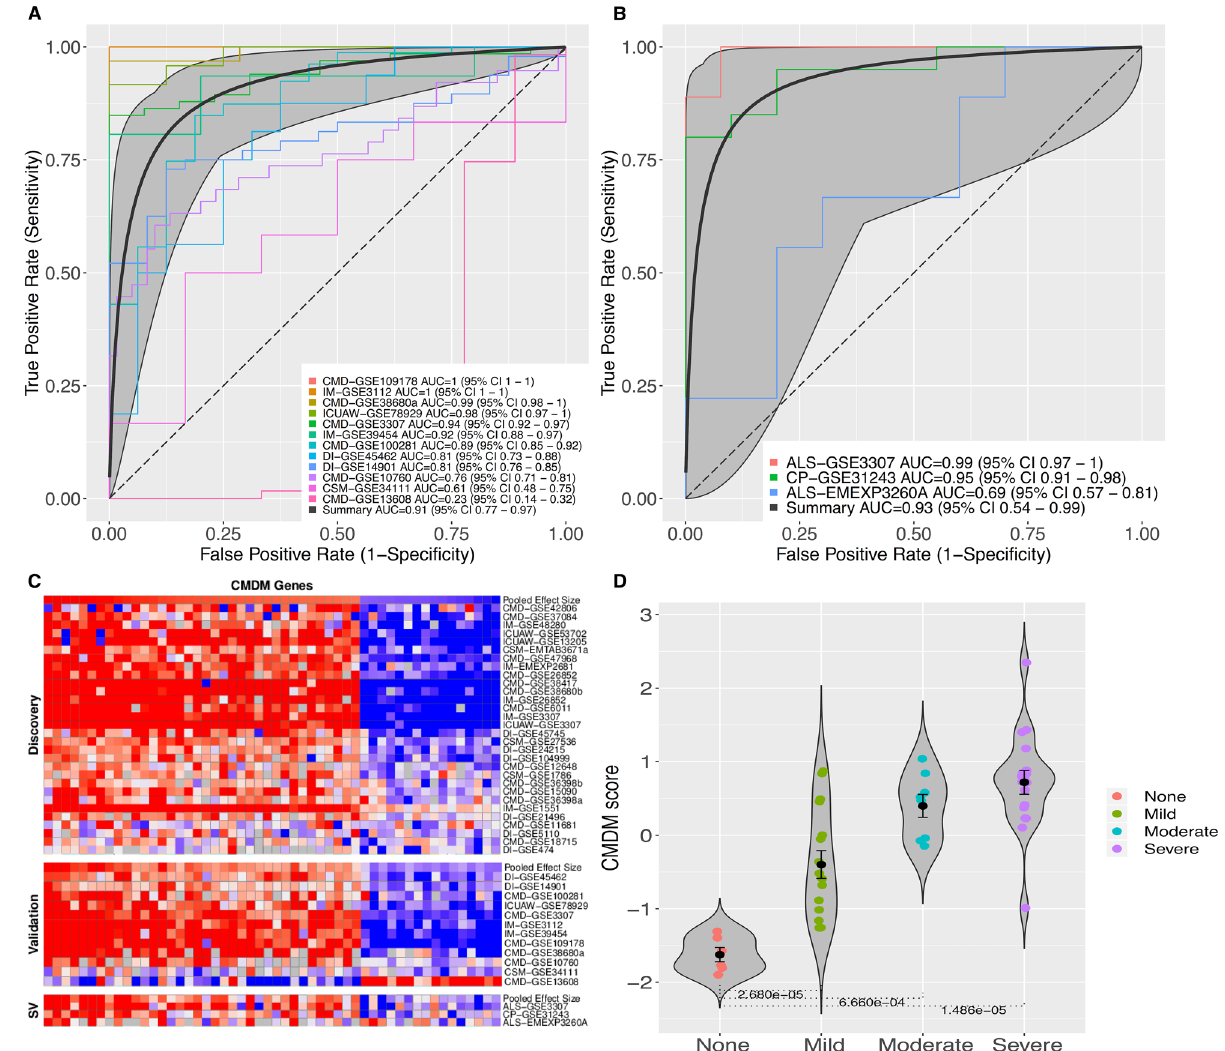
Figure 2. Validation of the 52-gene set of genes expressed across human muscle diseases. ( A ) ROC curves comparing 657 patients in the validation cohort. ( B ) ROC curves comparing 81 patients in the secondary validation cohort. ( C ) Heat map shows consistent differential expression in the majority of discovery, validation, and secondary validation cohort data sets. Columns represent CMDM genes ranked from the highest to the lowest standardized mean difference (Hedges’ g in z-scaled log 2 values) from left to right. Rows denote data sets used in each stage of meta-analysis, arranged by unsupervised hierarchical clustering using Ward’s minimum variance method. ( D ) Violin plots of CMDM muscle disease severity scores for a cohort of congenital muscle diseases, classified by degree of fibrosis (none, mild, moderate, severe), GSE109178. Error bars show middle quartiles. P values calculated with Wilcoxon rank-sum test. Jonckheere’s trend test shows significant association (two-tailed p ≤ 0.05) p = 4.45 × 10 –9 . Refer to Table 1 for data set information. ICUAW intensive care unit acquired weakness, IM inflammatory myopathies, DI disuse and immobility, CMD congenital muscle disorders, CSM chronic systemic diseases affecting muscle. Genes unavailable for a dataset are shown in